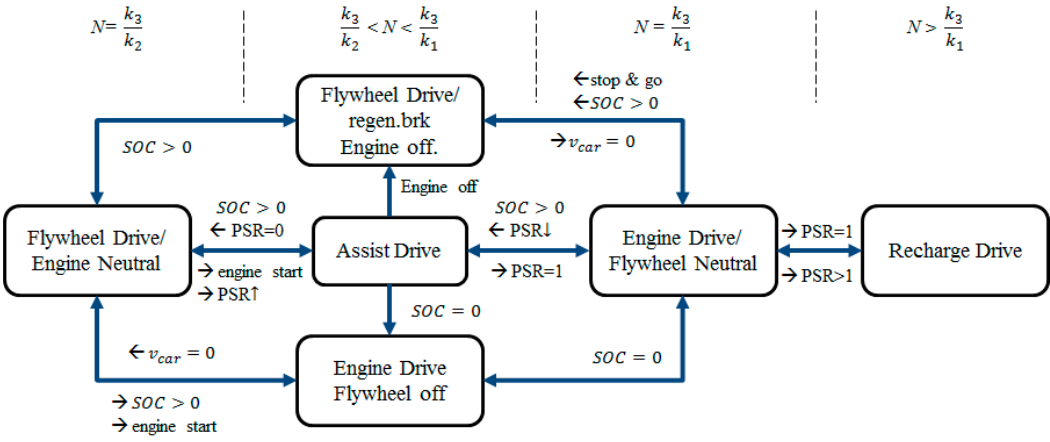
Figure 7. Operation state diagram of the PS-FHV.